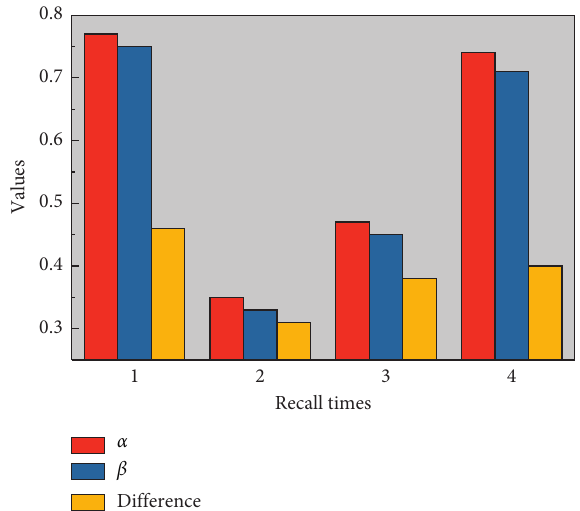
Figure 6: Effect of different proportions of text feature words on the results of clustering experiments. Figure 7: Recallofexperimentalresultswithdifferentvaluesof α and ß